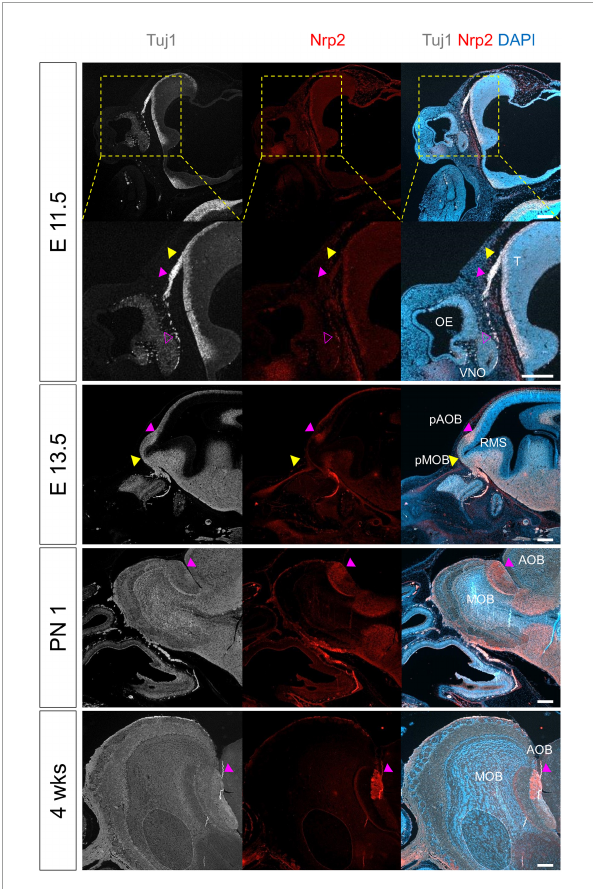
FIGURE4 Morphological and molecular changes during the development of OB. All images were obtained in the sagittal direction. Immunostaining with anti-Nrp2 antibody, anti-Tuj1 antibody, and DAPI at E11.5, E13.5, PN 1, and 4 weeks. Yellow arrows indicate the tip of the telencephalon, putative olfactory bulb, or OB; magenta hollow arrows indicate Tuj1 + and Nrp2 + vomeronasal nerve fibers migrated from VNO; and magenta solid arrows indicate putative accessory olfactory bulb or accessory olfactory bulb. T, telencephalon; OE, olfactory epithelium; VNO, vomeronasal organ; RMS, rostral migratory stream; (p)MOB, putative main olfactory bulb; (p)AOB, putative accessory olfactory bulb. Scale bar, 200 µ